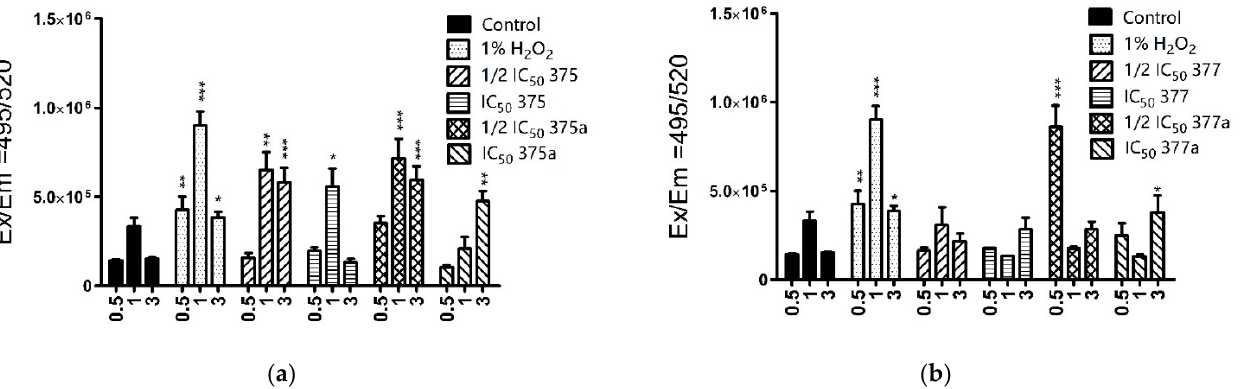
Figure 3. Cytosolic levels of reactive oxygen species in Ishikawa cells after 0.5, 1 and 3-h treatment with 375 (rhenium aspirin), 375a (aspirin) ( a ), 377 (rhenium indomethacin) and 377a (indomethacin) ( b ). Cells were preincubated with H 2 DCF-DA dye and then treated with the tested drugs. Data were obtained by measuring the fluorescence at Ex/Em = 495/520 nm. 1% H 2 O 2 was used as a positive control. Results were statistically compared with the negative control (untreated cells with 1% DMSO dissolved in cell culture medium). Two-way ANOVA with Bonferroni multiple comparison test was used for statistical analyses; * = p < 0.05, ** = p < 0.01, *** = p < 0.001.